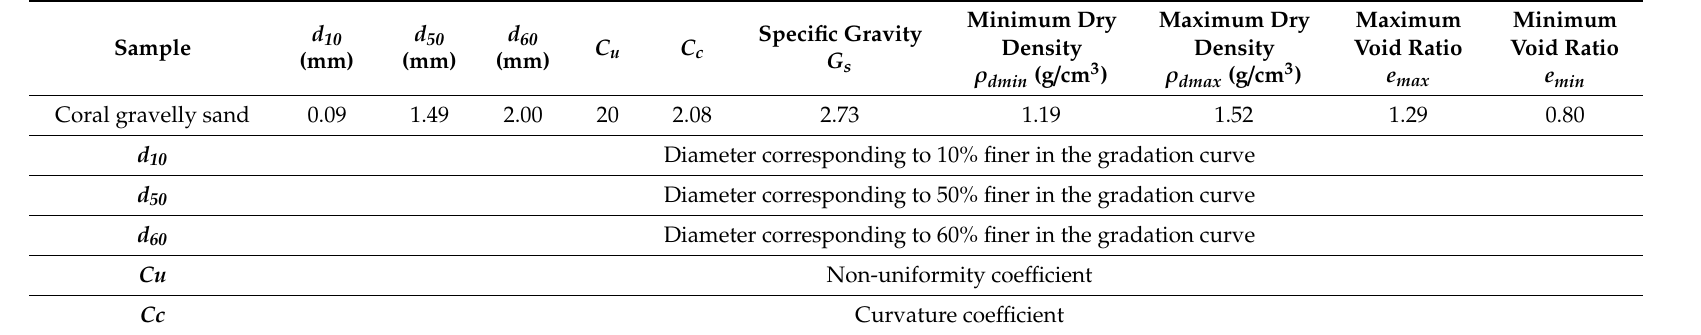
Table 1. Physical parameters of the coral sand